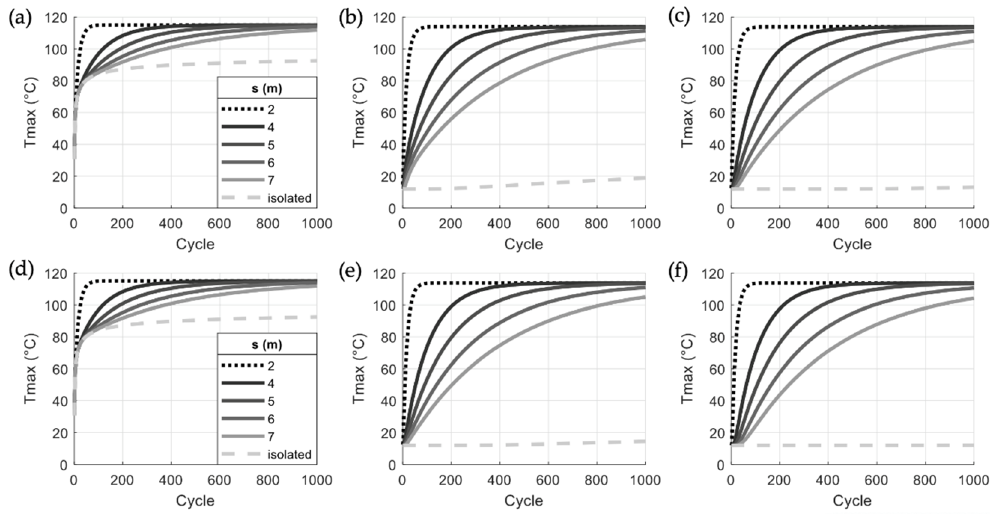
Figure 14. Maximum temperature in each loading cycle for different s at ( a ) the inner surface of the soil ( θ = 0°); ( b ) the quarter of the soil layer ( θ = 0°); ( c ) the center between two piles ( θ = 0°); ( d ) the inner surface of the soil ( θ = 45°); ( e ) the quarter of the soil layer ( θ = 45°); and ( f ) the center between two piles ( θ = 45°).